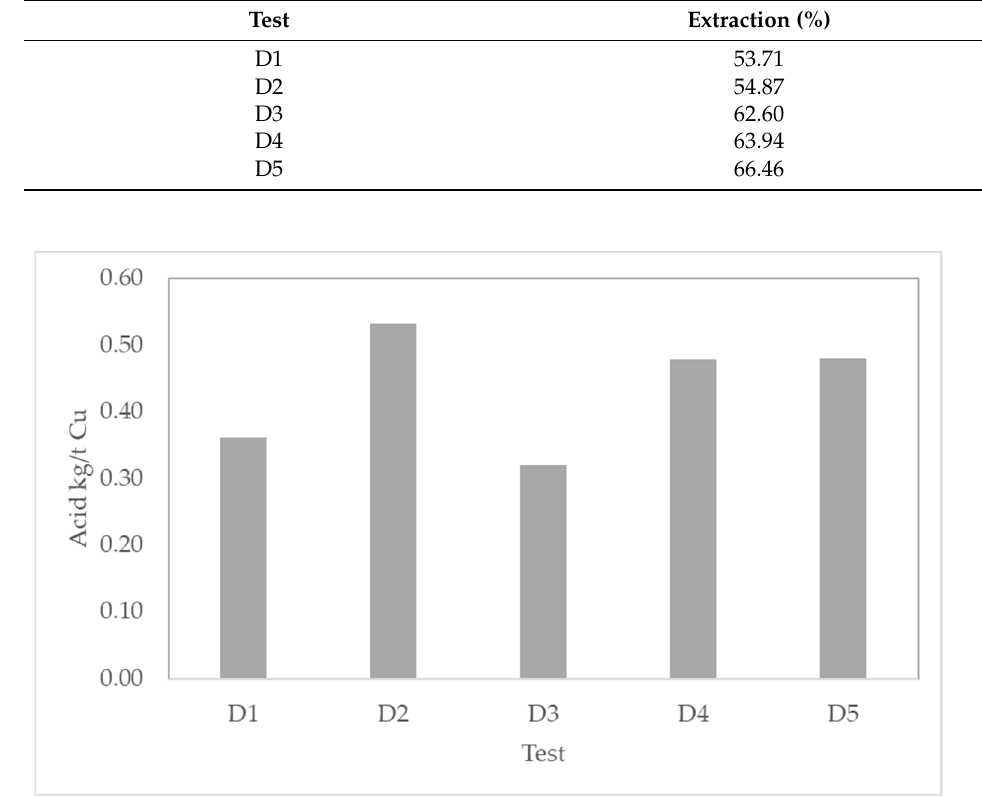
Table 7. Extraction in percentage for tests D.